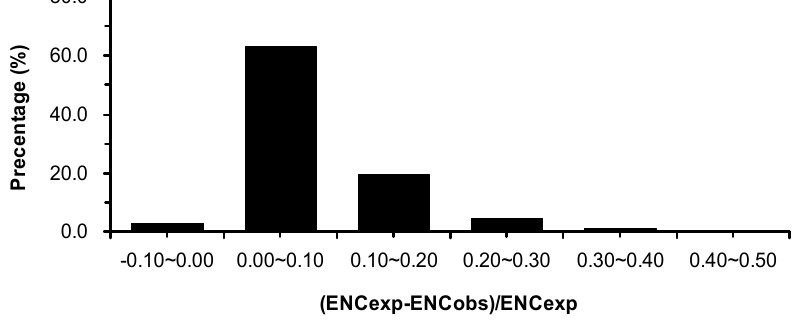
Figure 2. The frequency distribution of effective number of codons (ENC) ratio.